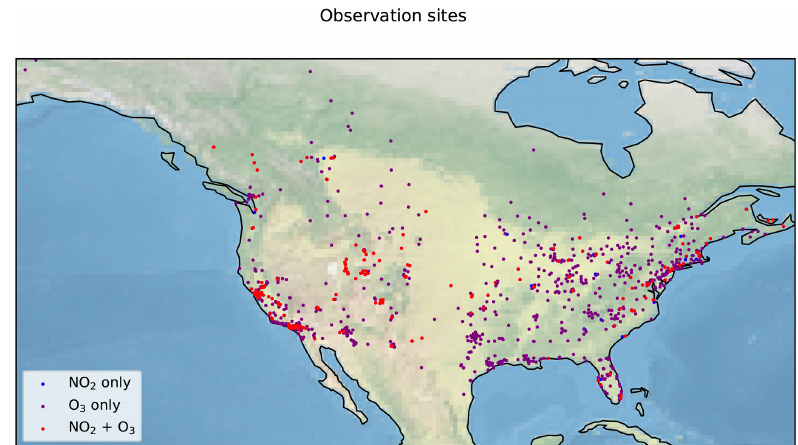
Figure A3. Close-up image of North American observation sites included in the analysis. Red points indicate sites with both NO 2 and O 3 observations, purple points show locations with O 3 observations only, and blue points show locations with NO 2 observations only.